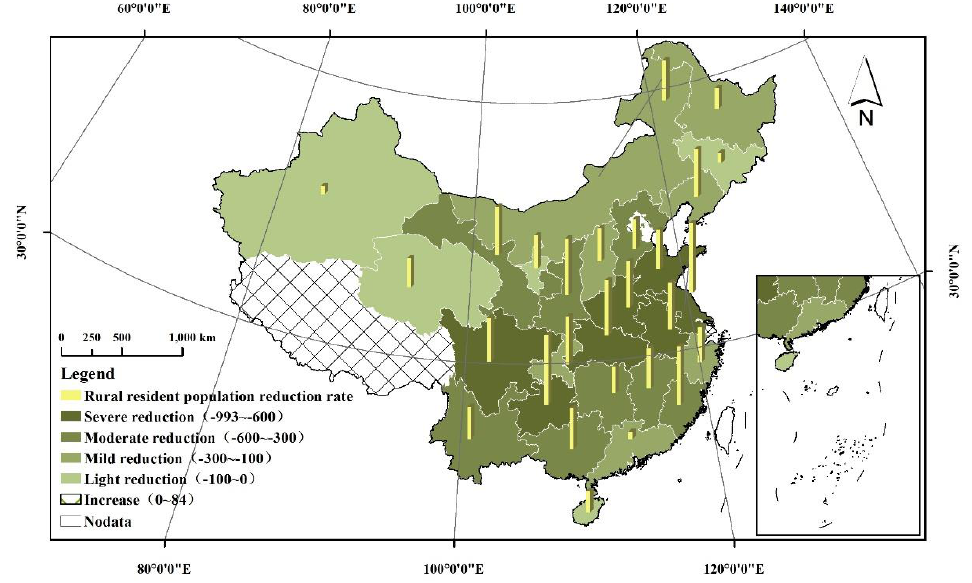
Figure 2. Spatial pattern of the absolute increase and average annual reduction rate of the rural permanent population from 2009 to 2016.